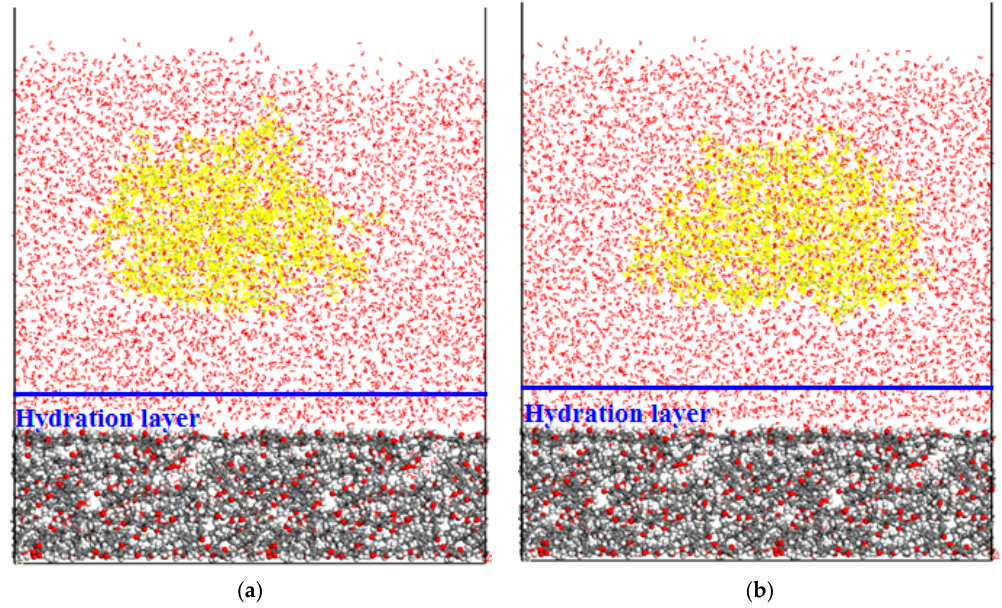
Figure 8. Initial ( a ) and final ( b ) configurations of the coal-water-collector (CWC) adsorption system.